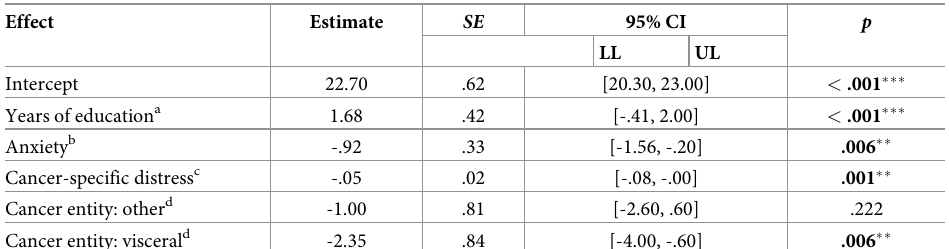
Table 5. Results of the stepwise regression analysis for self-acceptance in women ( n =